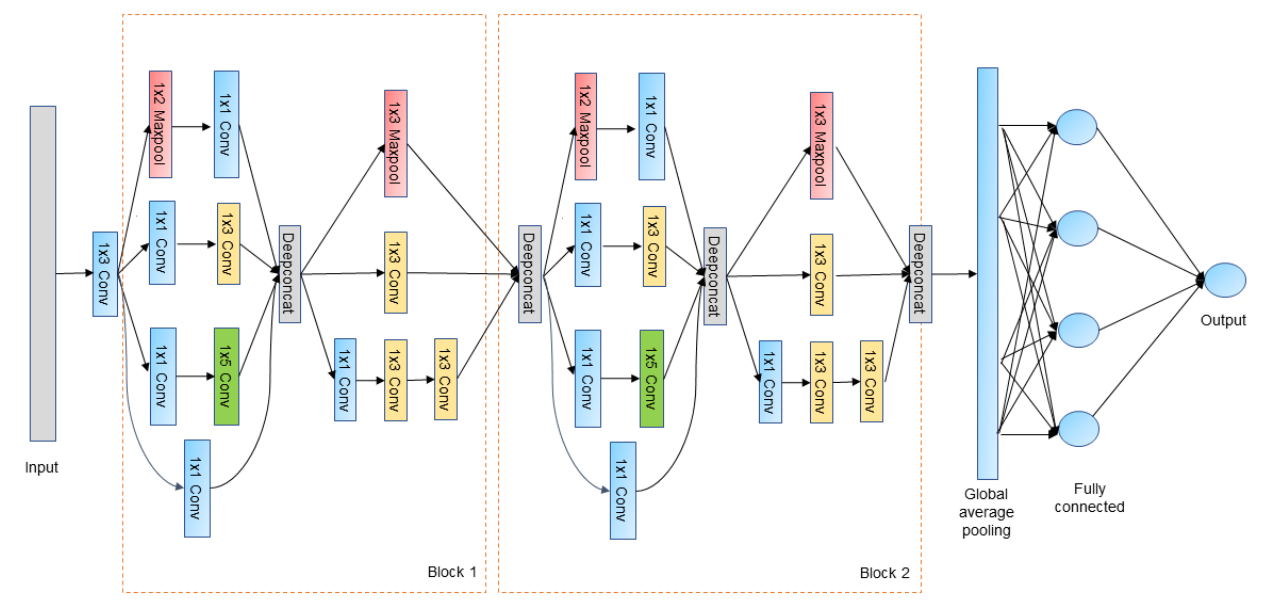
Figure 5. Multi-scale convolutional neural network.